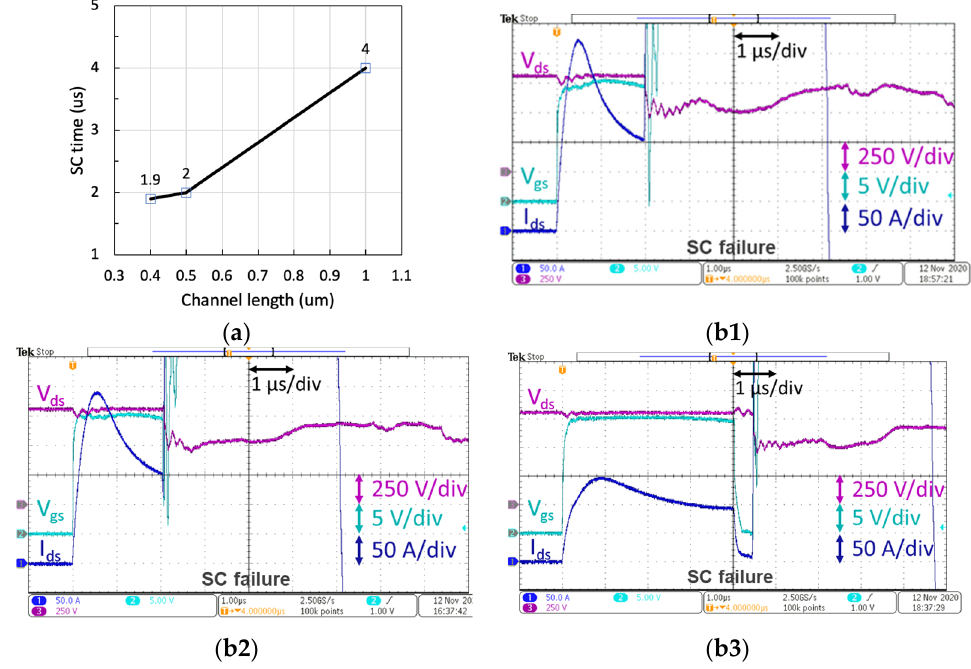
( b ) Figure 19. ( a ) Cross-sectional view of a half-cell of the MOSFET showing the highly doped P+ shielded region; ( b ) Graph showing the drain current reduction with increase in channel length